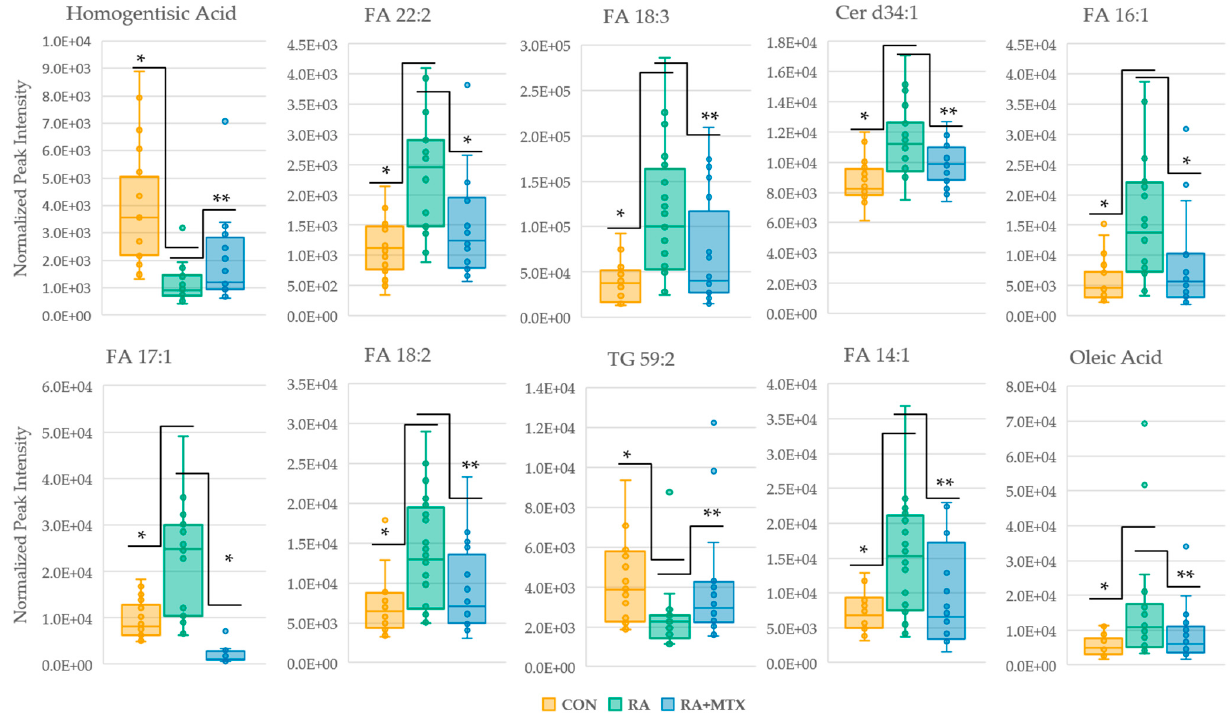
Figure 5. Box and whisker plots of statistically significant metabolites ( * = p < 0.005 and ** = p < 0.05) identified in volcano plots displaying a correction towards metabolite levels of healthy control. Control (yellow); RA (green); RA + MTX (blue); fatty acid (FA); ceramide (Cer); triglyceride (TG).